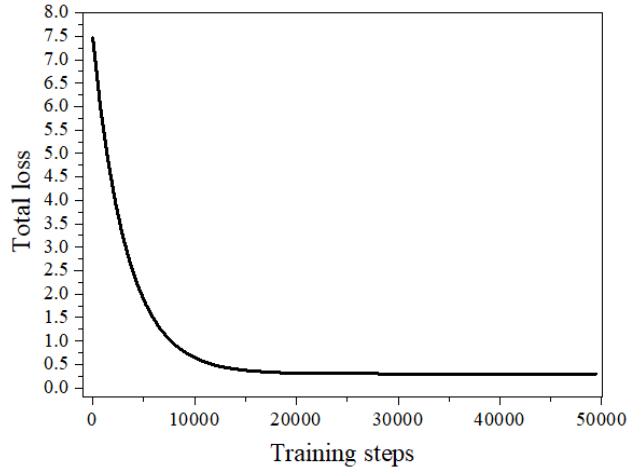
Figure 12. Loss decline curve. As the accuracy of the angle measuring instrument had a minimum of 1 ◦ , images of 1 ◦ , 3 ◦ , 5 ◦ , and 7 ◦ were measured and identified for testing. Three images were collected at each angle. Through the self-training model, the best results identified are shown in Figure 13. Sensors 2021 , 21 , x FOR PEER REVIEW